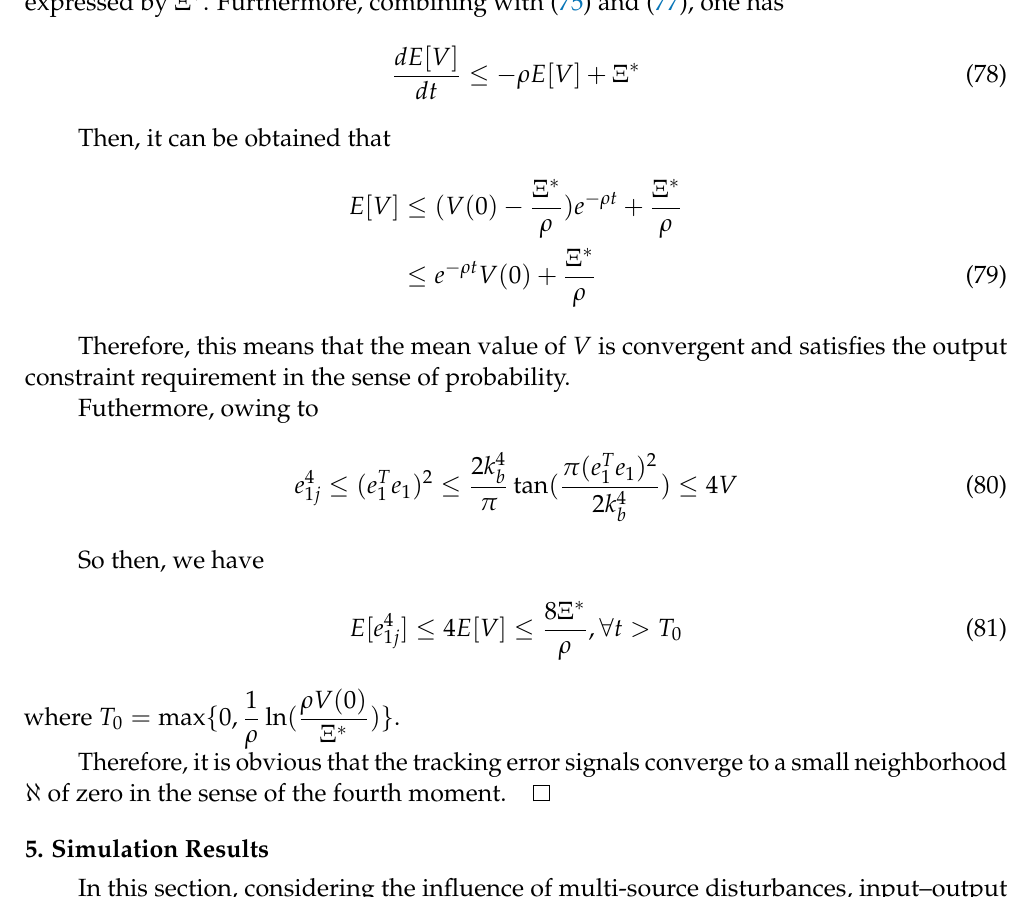
Table 1. The physical structure parameters of NSV (partly). Meaning Value Unit vehicle length 60.69 m/s vehicle mass 136,820 kg reference area 334.73 mean aerodynamic chord 24.384 wing string length